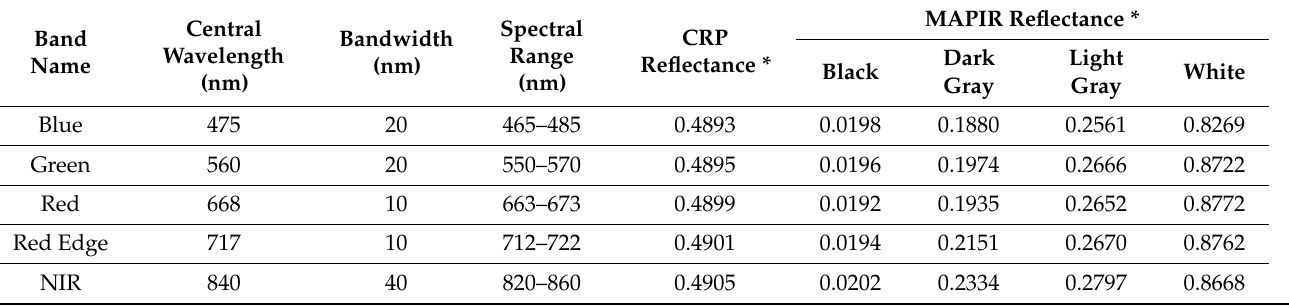
Table 1. Spectral characteristics of the RedEdge-M camera and calibration